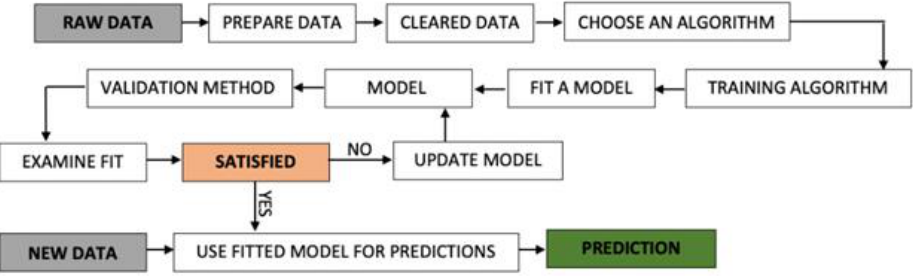
Figure 3. A machine learning typical workflow (original figure).